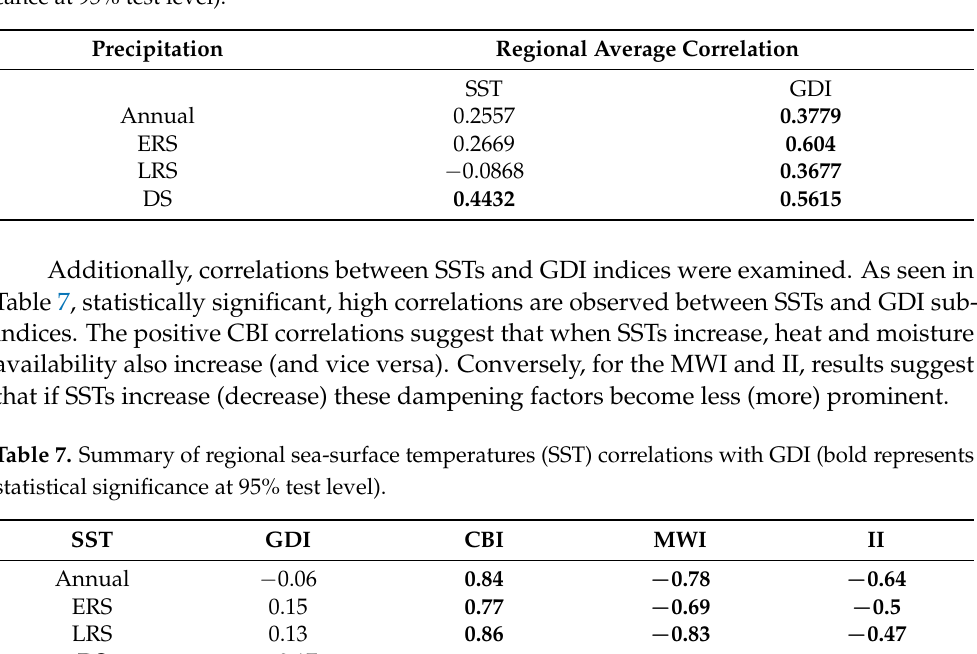
Table 6. Summary of regional precipitation correlations with SST and GDI (bold represents signifi- cance at 95% test level).